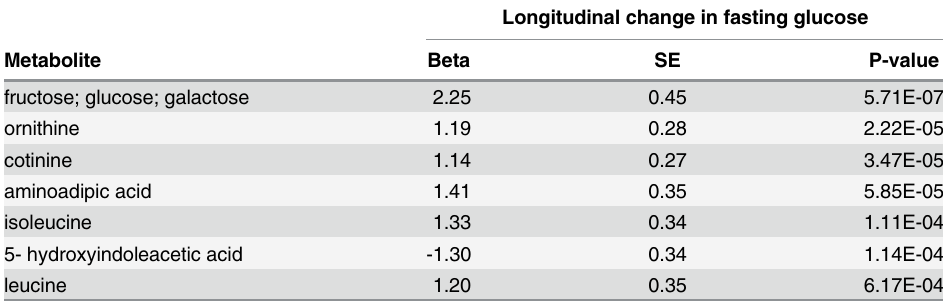
Table 4. Metabolites associated with longitudinal changes in fasting